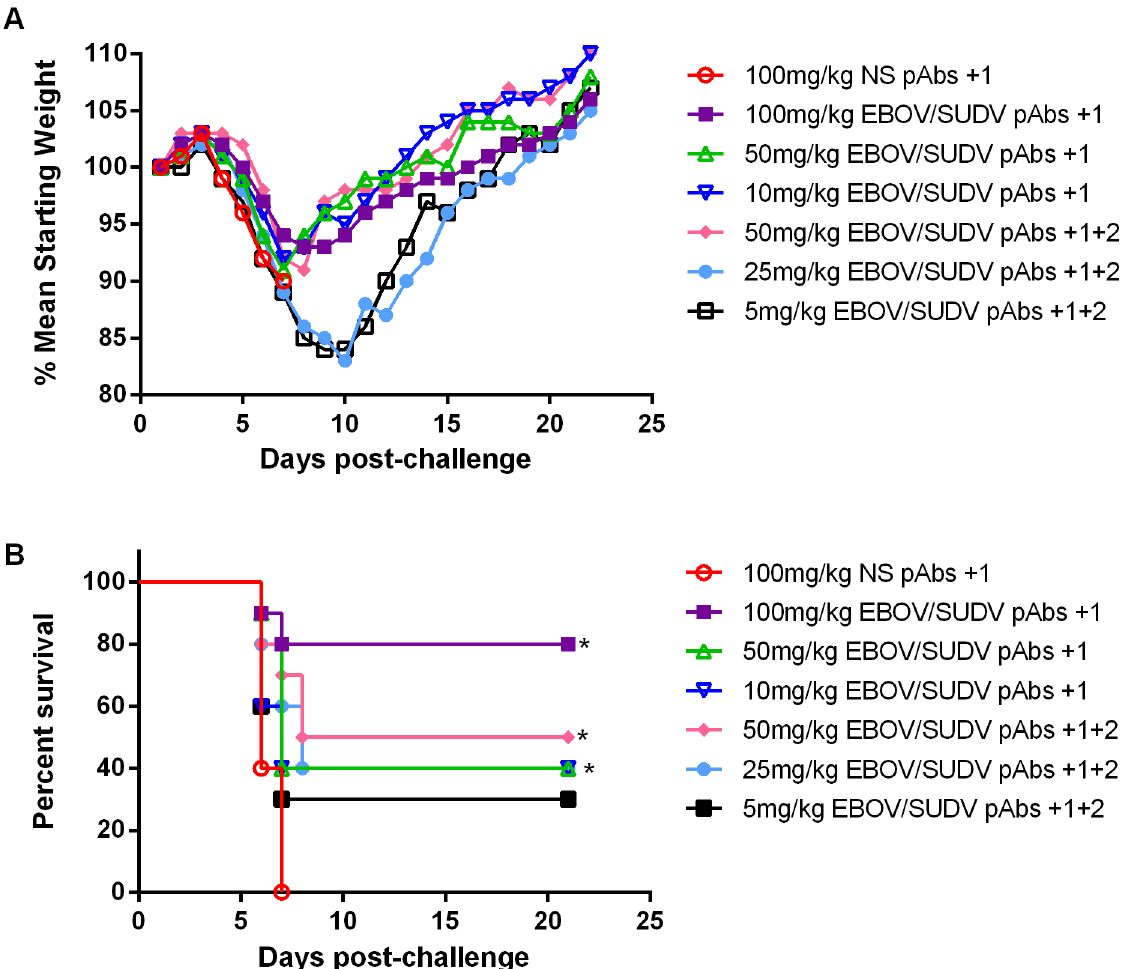
Fig 5. Weight loss and survival of BALB/c mice administered high, medium, or low doses of purified EBOV/SUDV human pAbs after maEBOV challenge. Groups of BALB/c mice (N = 10) received a single IP injection of 100mg/kg NS pAbs, 100 mg/kg EBOV/SUDV pAbs, 50 mg/kg EBOV/SUDV pAbs, or 10 mg/kg EBOV/SUDV pAbs one day after challenge or 50 mg/kg EBOV/SUDV pAbs, 25 mg/kg EBOV/SUDV pAbs, or 5 mg/kg EBOV/SUDV pAbs on day 1 and day 2 after challenge with 100 pfu maEBOV. (A) Mean weight was determined daily for each dosing group and graphed as the percent mean of the starting weight. All mice receiving the NS pabs succumb by day 8 post-challenge. (B) Kaplan-Meier survival curves indicating the percentage of surviving mice at each day of the 21-day post-challenge observation period are shown. The p-values for the following comparisons are as follows: 100 mg/kg NS pAbs vs. 100 mg/kg EBOV/SUDV pAbs +1 ( p = 0.0003), 100 mg/kg NS pAbs vs. 50 mg/kg EBOV/SUDV pAbs +1 ( p = 0.0059), NS pAbs vs. 10 mg/kg EBOV/ SUDV pAbs +1 ( p = 0.0630), NS pAbs vs. 50 mg/kg EBOV/SUDV pAbs +1 and +2 ( p = 0.002), NS pAbs vs. 25 mg/kg EBOV/SUDV pAbs +1 and +2 ( p = 0.0046), NS pAbs vs. 5mg/kg EBOV/SUDV pAbs +1 and +2 ( p = 0.1082), 100mg/kg EBOV/SUDV pAbs +1 vs. 50 mg/kg EBOV/SUDV pAbs +1 and +2 ( p = 0.1988), 50 mg/kg EBOV/SUDV +1 vs. 25 mg/kg EBOV/SUDV pAbs +1 and +2 ( p = 0.9968), and 10 mg/kg EBOV/SUDV pAbs +1 vs. 5 mg/kg EBOV/ SUDV pAbs +1 and +2 ( p = 0.7275). Significant differences between survival curves are denoted by ( * ) where p < 0.05.